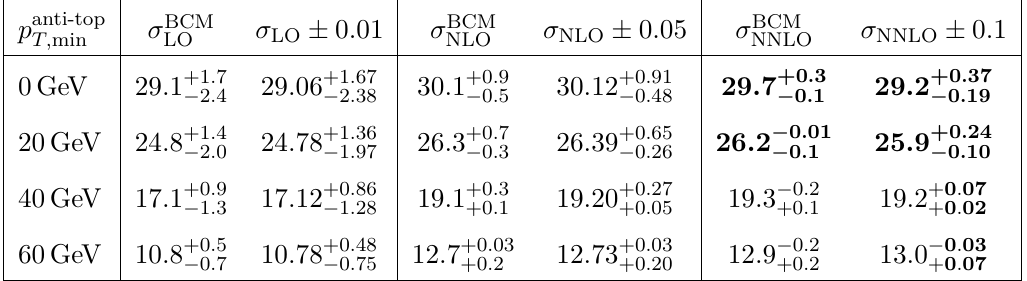
Table 3 . Comparison with fully inclusive anti-top-quark production results from Brucherseifer, Caola, Melnikov in ref. [36]. Cross-sections in picobarns. Scale uncertainties in super- and subscript from simultaneous variation of µ R = m t and µ F = m t by a factor of two and one half, respectively. p anti-top T,